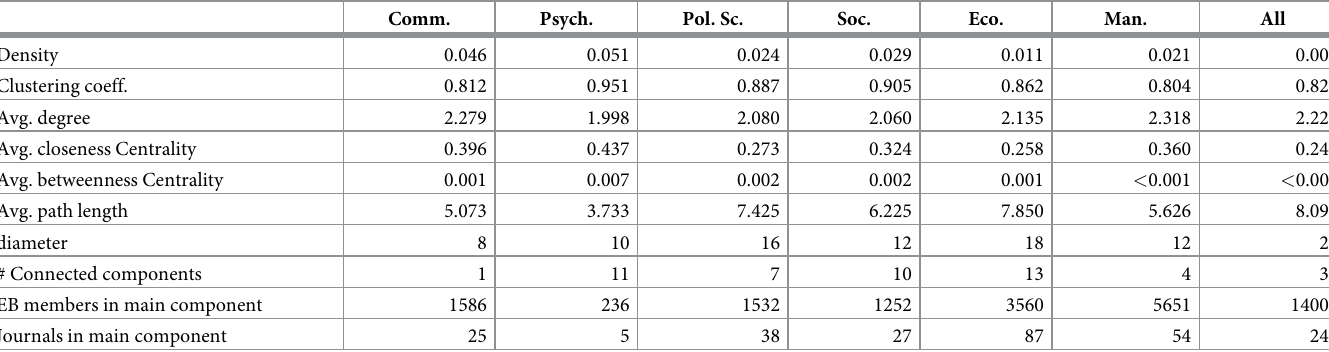
Table 2. Metrics of the networks for the six fields and for the complete network.